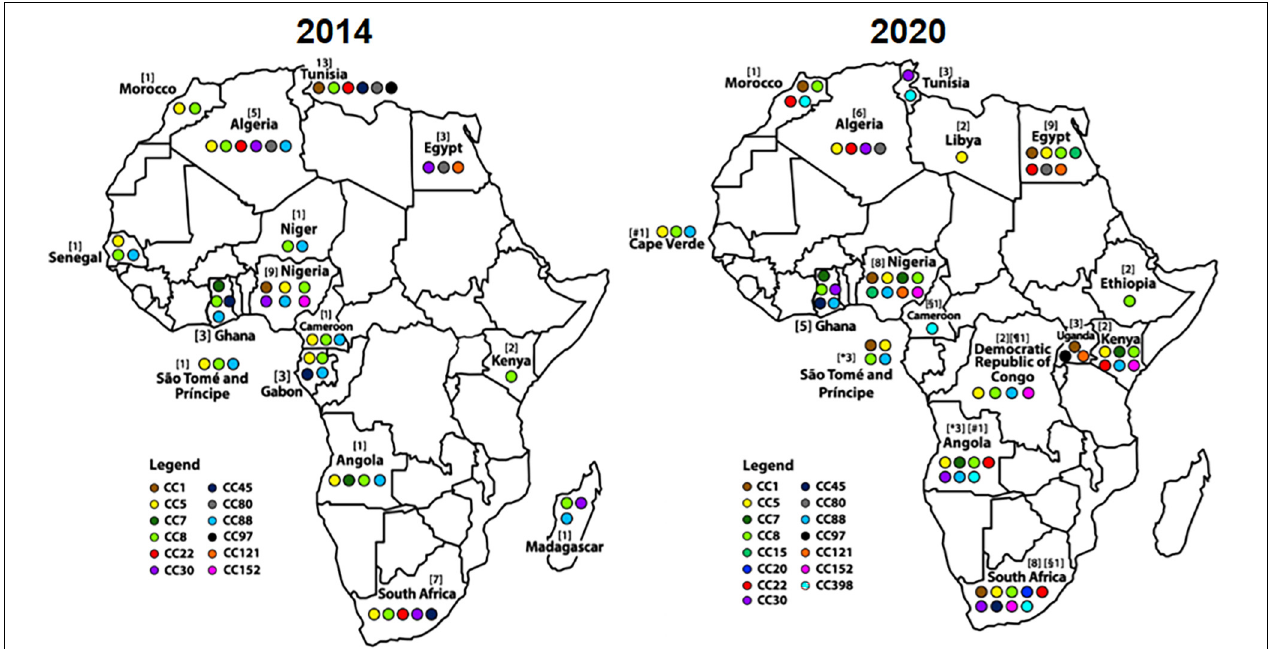
FIGURE 3 | Distribution of methicillin-resistant Staphylococcus aureus (MRSA) clones in Africa as reported (Abdulgader et al., 2015) and this current study (2020). Each clonal complex (CC) is represented with colored oval shape and eligible studies carried out in each country is indicated in parenthesis. The symbols (#, *, §, or ¶) on the right side (2020) depict data that were extracted from the same multicentre